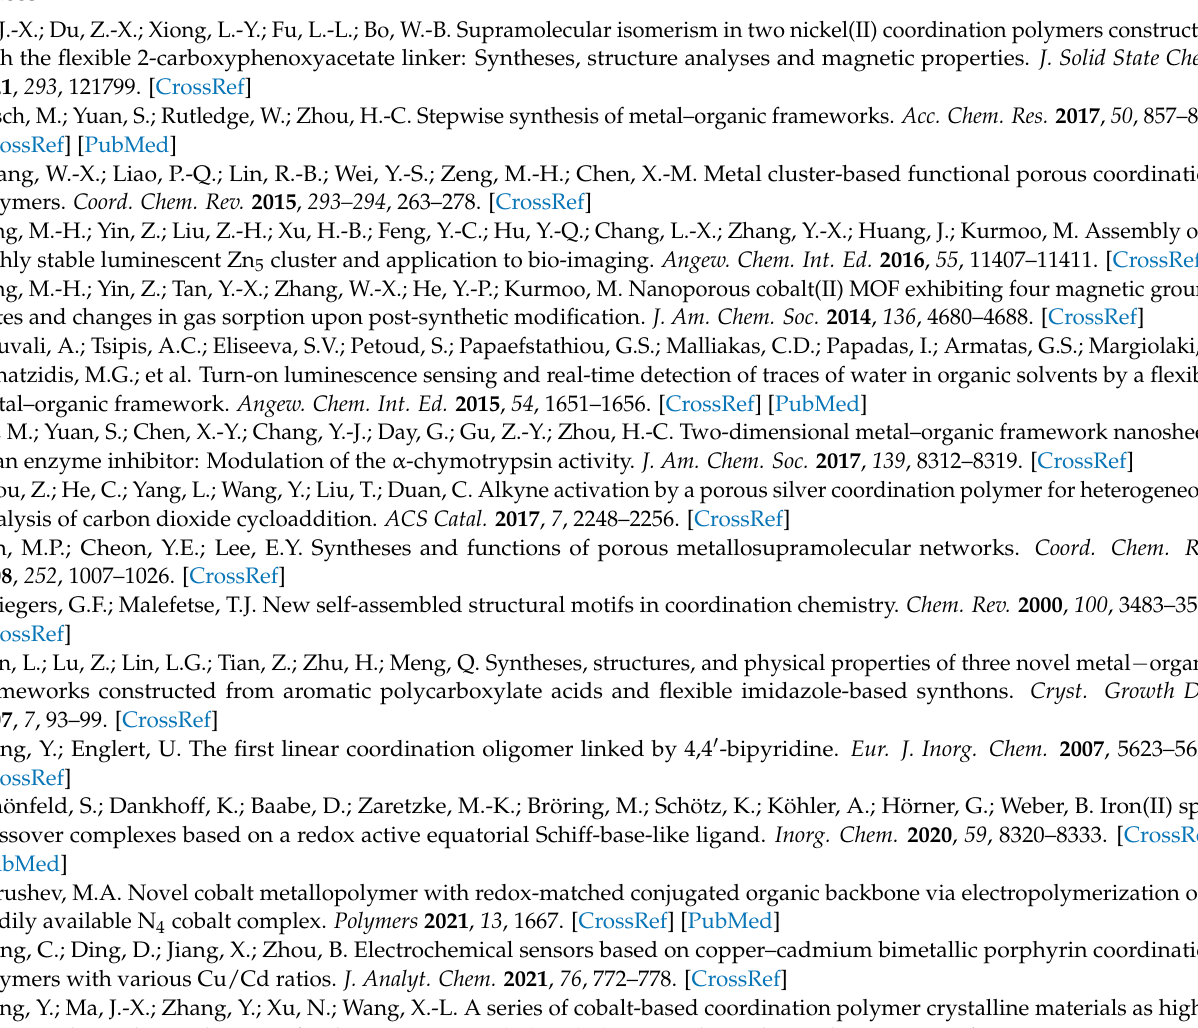
Figure S6. TGA/DTA curve of {[Ni(4,4’-bpy)(H 2 O) 4 ](6-Onic) 2 · 2H 2 O} n ( 2 ). Deposition numbers 2122274 (for 1 ) and 2122275 (for 2 ) contain the supplementary crystallographic data for this